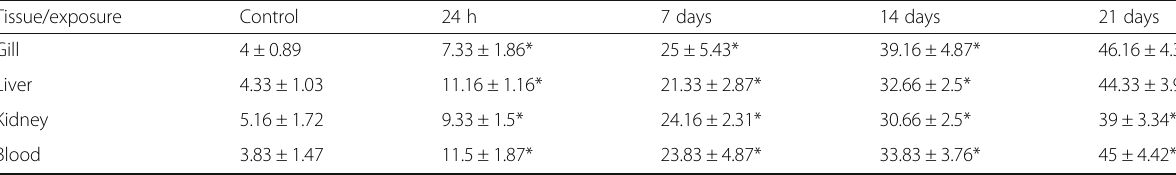
Table 5 % of DNA damage in tissues of C. carpio on exposure to karanjin Tissue/exposure